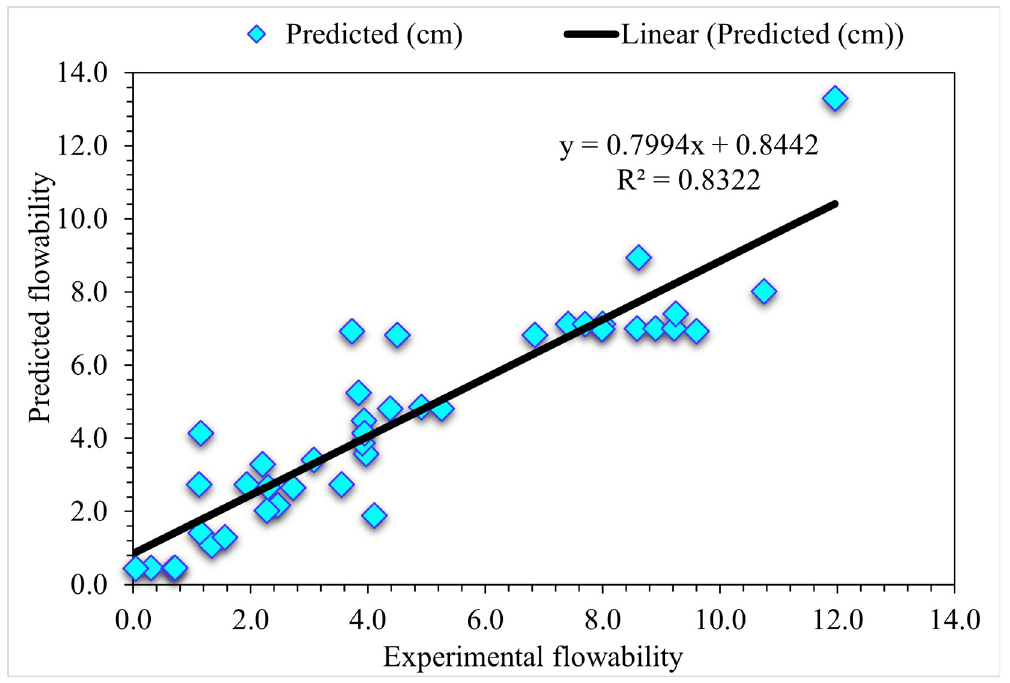
Fig 4. DT predicted and experimental values—UHPC